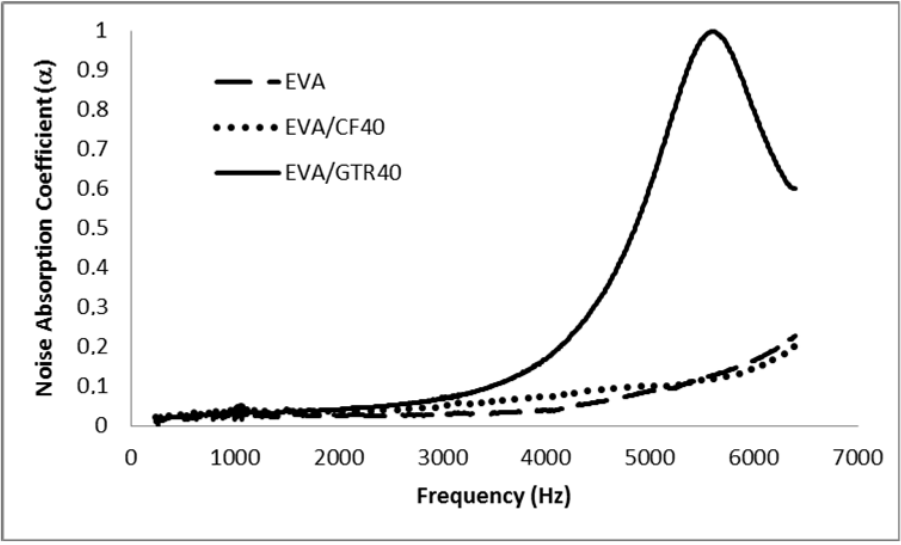
Figure 12. α values for EVA and GTR/EVA and CFs/EVA composites at 40 % composition.